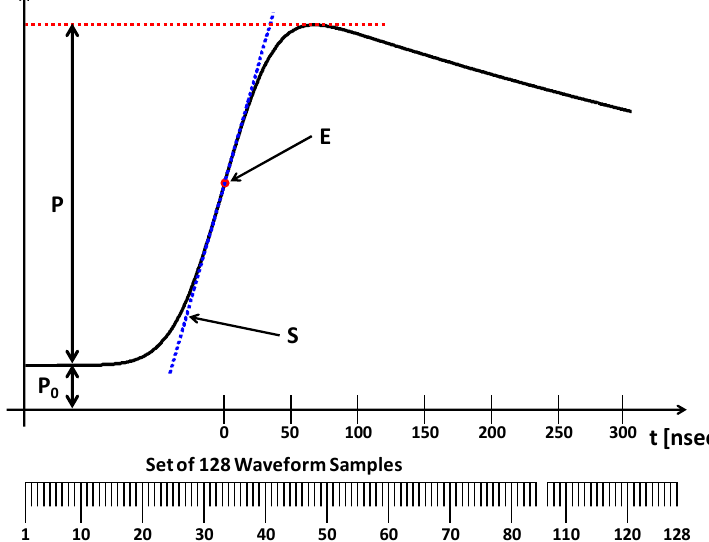
Figure 1. Typical altimeter waveform over sea surface. P useful signal amplitude (related to wind speed); E the epoch at mid-height (related to SSL) and S the leading edge slope (related to H